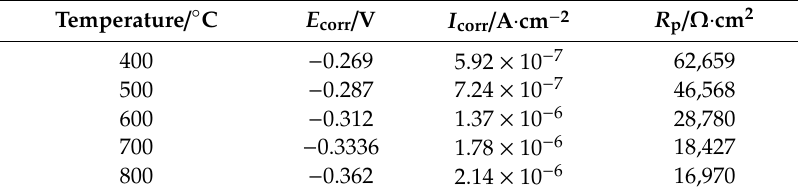
Table 5. E corr , I corr , and R p values of Ni coatings after treatments at high temperatures.